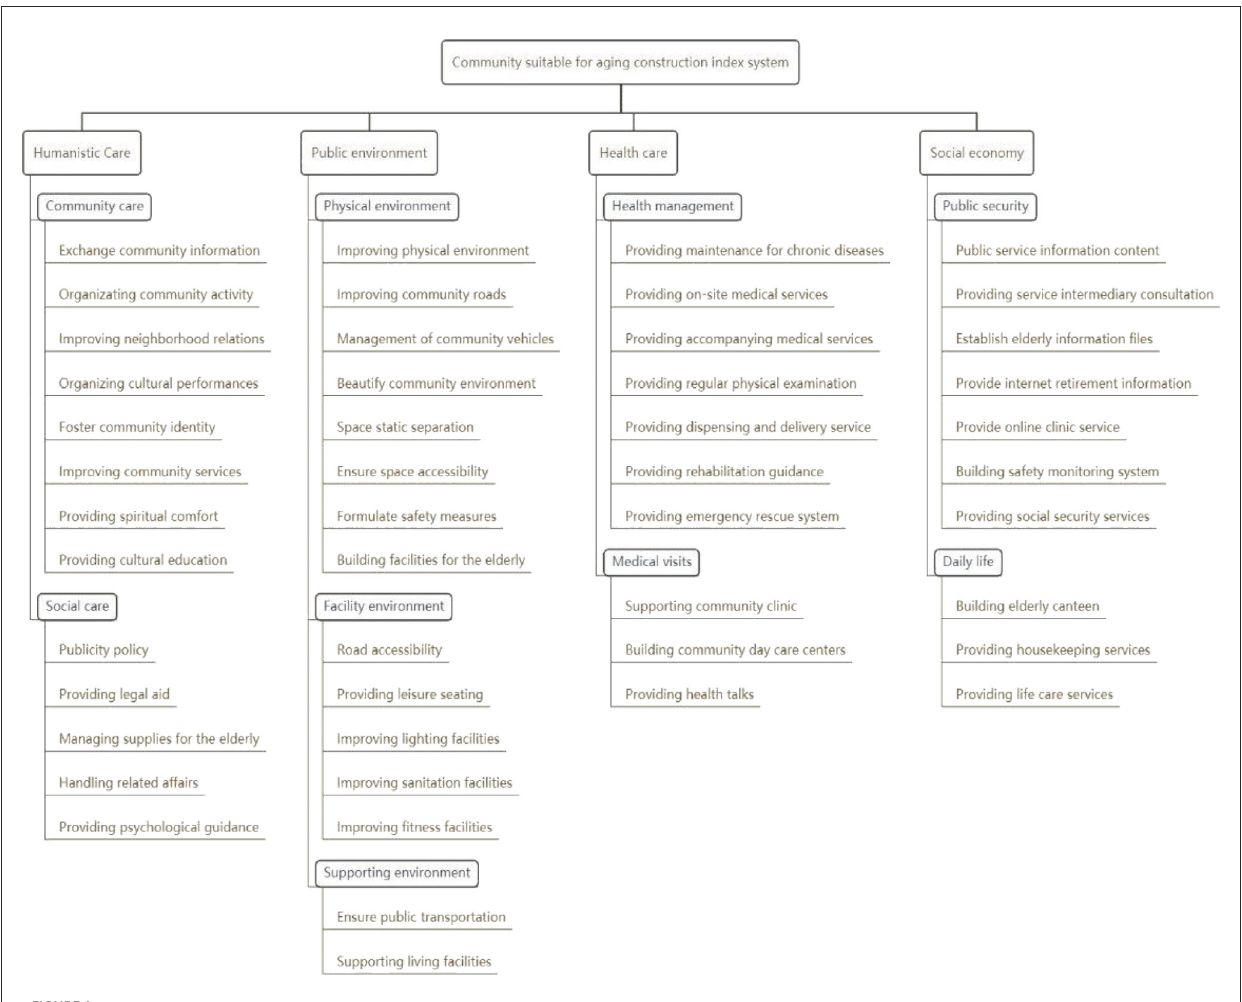
FIGURE1 Evaluation index system of the aging construction of